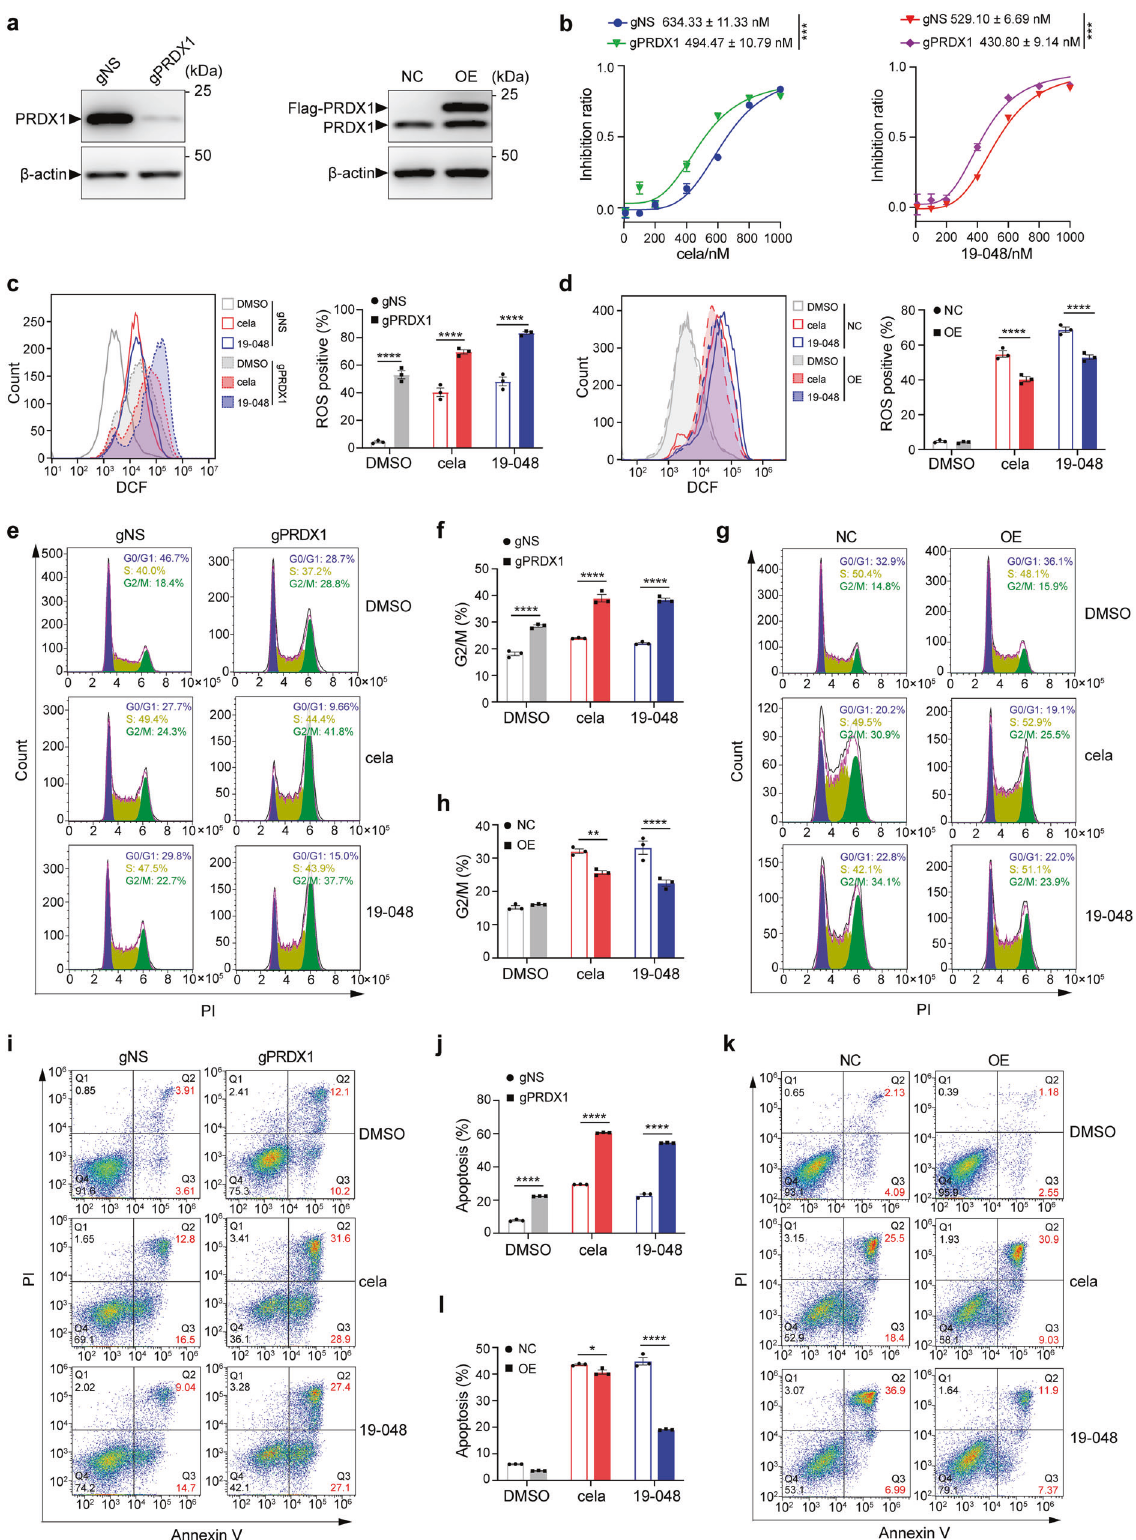
weight loss, whereas compound 19-048 caused 7.3% body weight loss as compared to DMSO control (data calculated from average body weight of DMSO control or compound 19-048 treatment group from gNS and gPRDX1 at day 12). To determine the in vivo